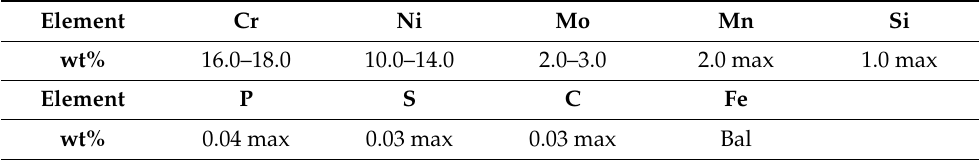
Table 1. Chemical composition of 316 L stainless steel